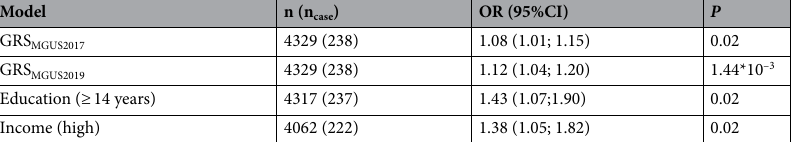
Table 2. Sex-and age adjusted odds ratios (OR) and 95% confidence intervals (95% CI) for the main effects on MGUS status in four separate logistic regression models including either the MGUS-associated genetic risk scores (GRS), dichotomized education or income (lower category as reference).